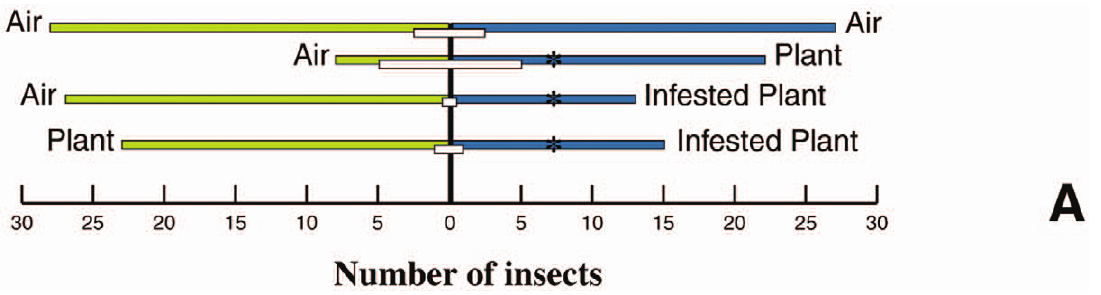
Figure 1. Response of C.herbacea in a Y-tube olfactometer when offered to M.aquatica cuttings of undamaged and C.herbacea - infested leaves versus pure GC-grade air. A x 2 test served to evaluate differences from a 50:50 distribution over two olfactometer arms. Insects that did not reach the end of either olfactometer arm within 10 min (NC: no choice) are indicated by white bars. The asterisks indicate significant (P , 0.05) differences.